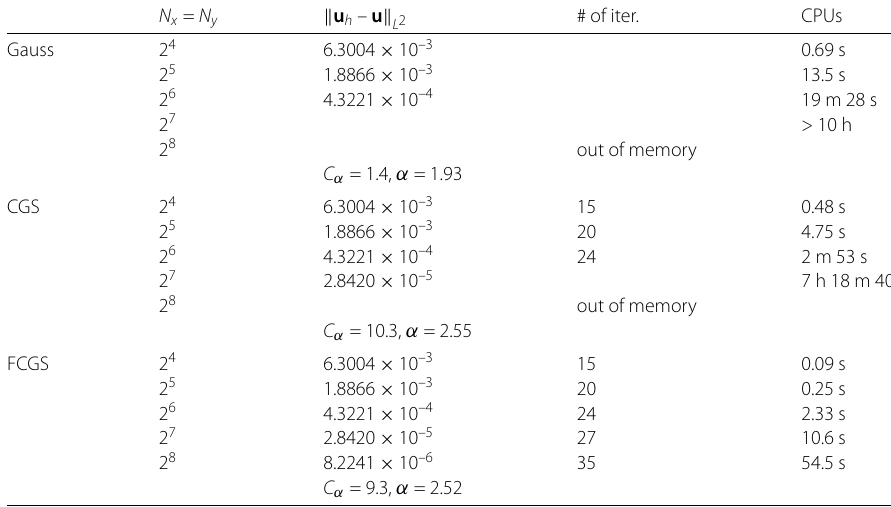
# of iter. CPUs L 2